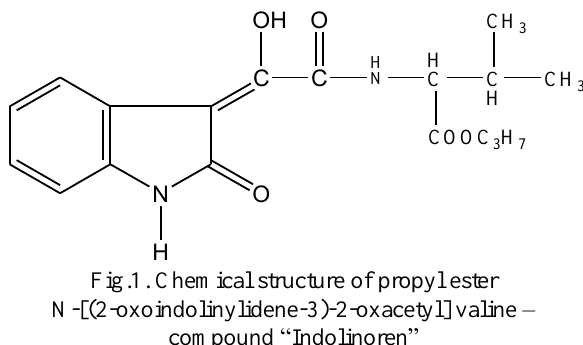
Fig.1. Chemical structure of propyl ester